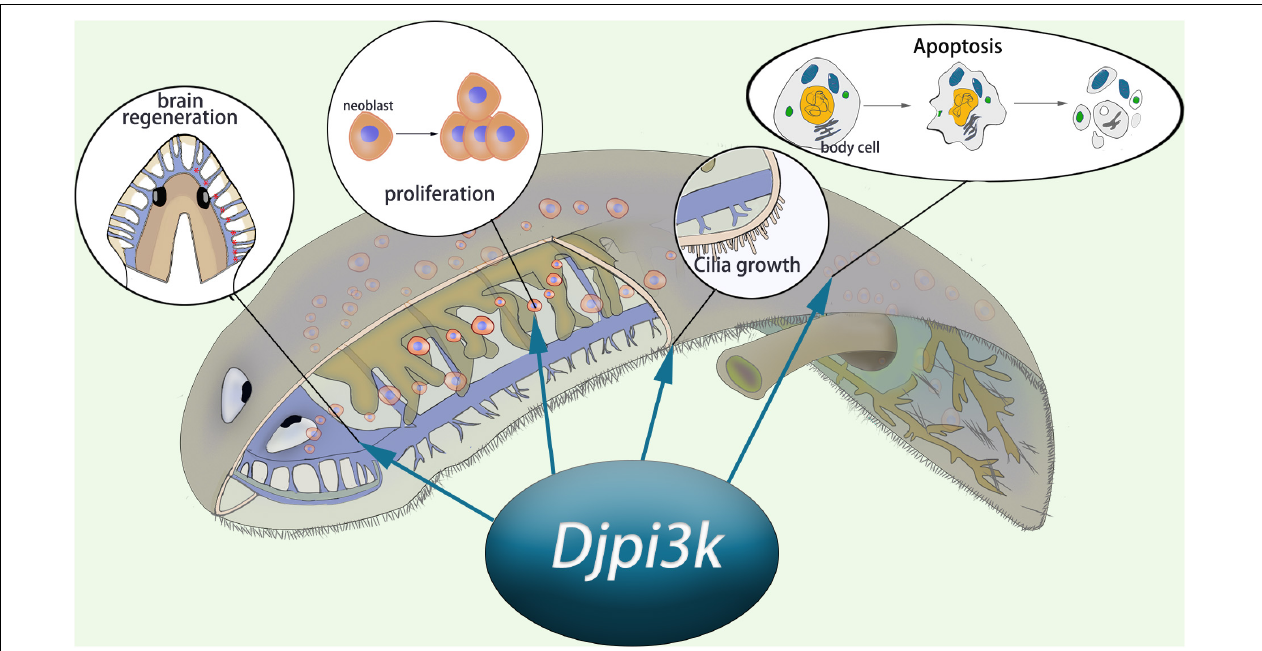
FIGURE 7 | Schematic representation of the essential role of Djpi3k in planarian regeneration and tissue